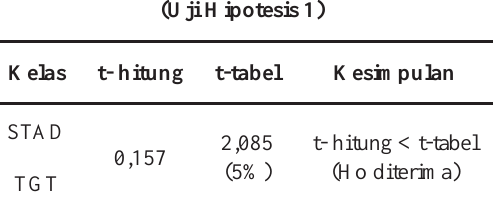
108 Komparasi Penerapan Model ... (Kukuh Andri